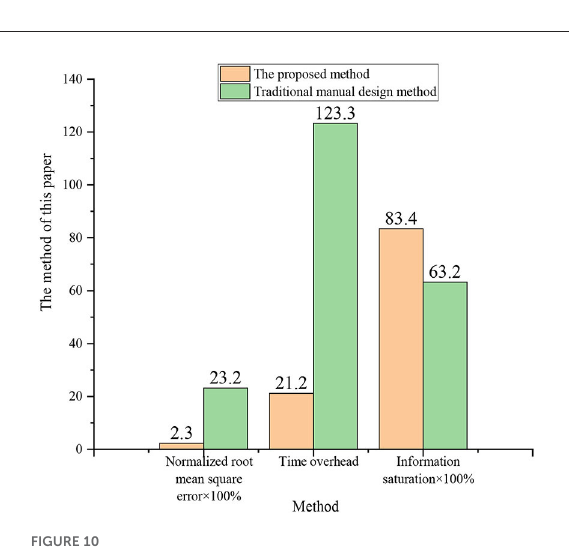
Comparison of test